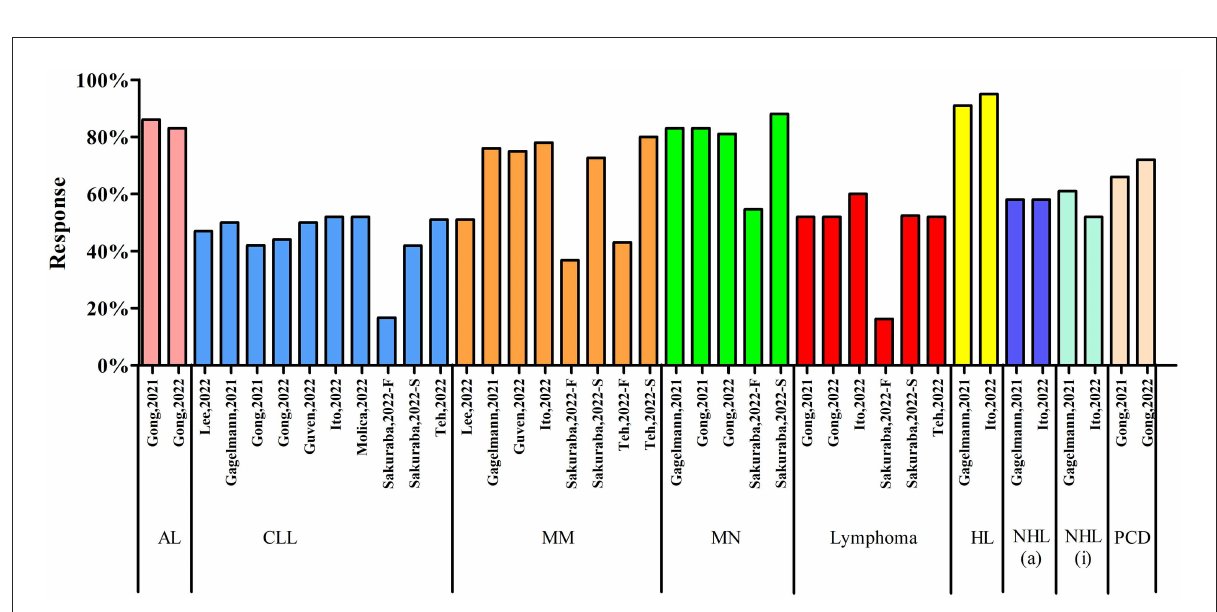
FIGURE8 Subgroup analysis according to cancer types. AL, acute leukemia; CLL, chronic lymphocytic leukemia; MM, multiple myeloma; MN, myeloproliferative neoplasms; HL, Hodgkin’s lymphoma; NHL(a), aggressive non-Hodgkin’s lymphoma; NHL(i), indolent non-Hodgkin’s lymphoma; PCD, plasma cell